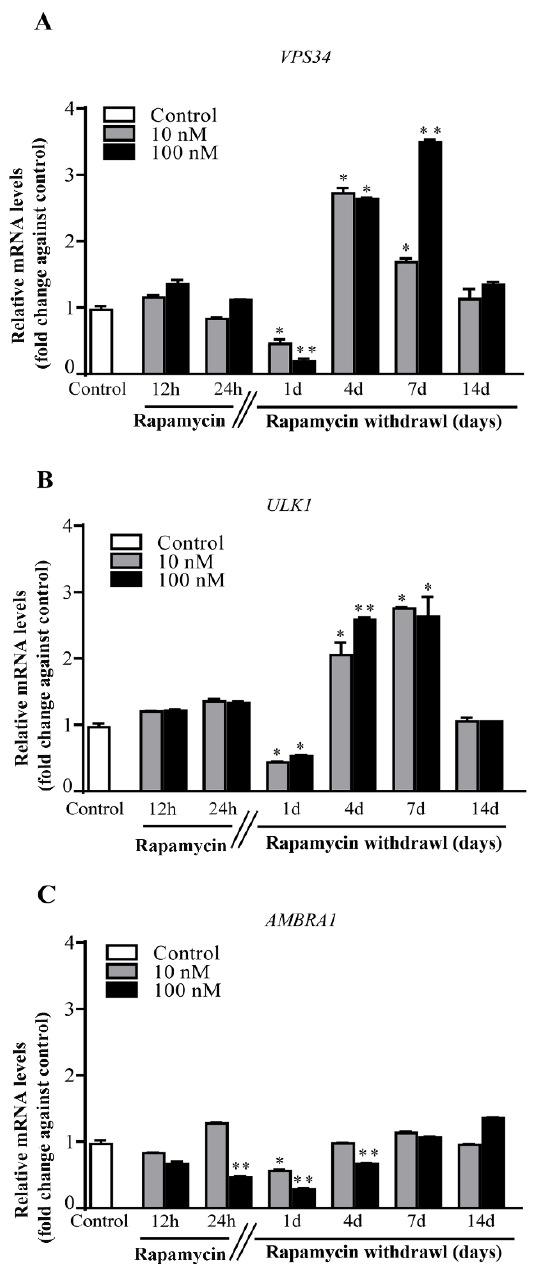
Figure 4. Rapamycin increases the mitophagy genes VPS34 and ULK1 while decreases AMBRA1 . RT-PCR for ( A ) VPS34 , ( B ) ULK1 , ( C ) AMBRA1 . In detail, VPS34 and ULK1 were depressed compared with controls a 1 d following rapamycin (both 10 nM and 100 nM) withdrawal. Later on, a marked increase in both genes was measured at 4 d and 7 d, going back to control levels at 14 d. In contrast, AMBRA1 never increased compared with controls. In detail, as occurring for VPS34 and ULK1 , AMBRA1 decreases at 1 d following rapamycin (both 10 nM and 100 nM) withdrawal. Such a decrease was evident also during rapamycin administration and at 4 d of withdrawal, when the highest dose (100 nM) of rapamycin was administered. Counts represent the mean ± SD. * p ≤ 0.05 compared with control. ** p ≤ 0.05 compared with control and 10 nM